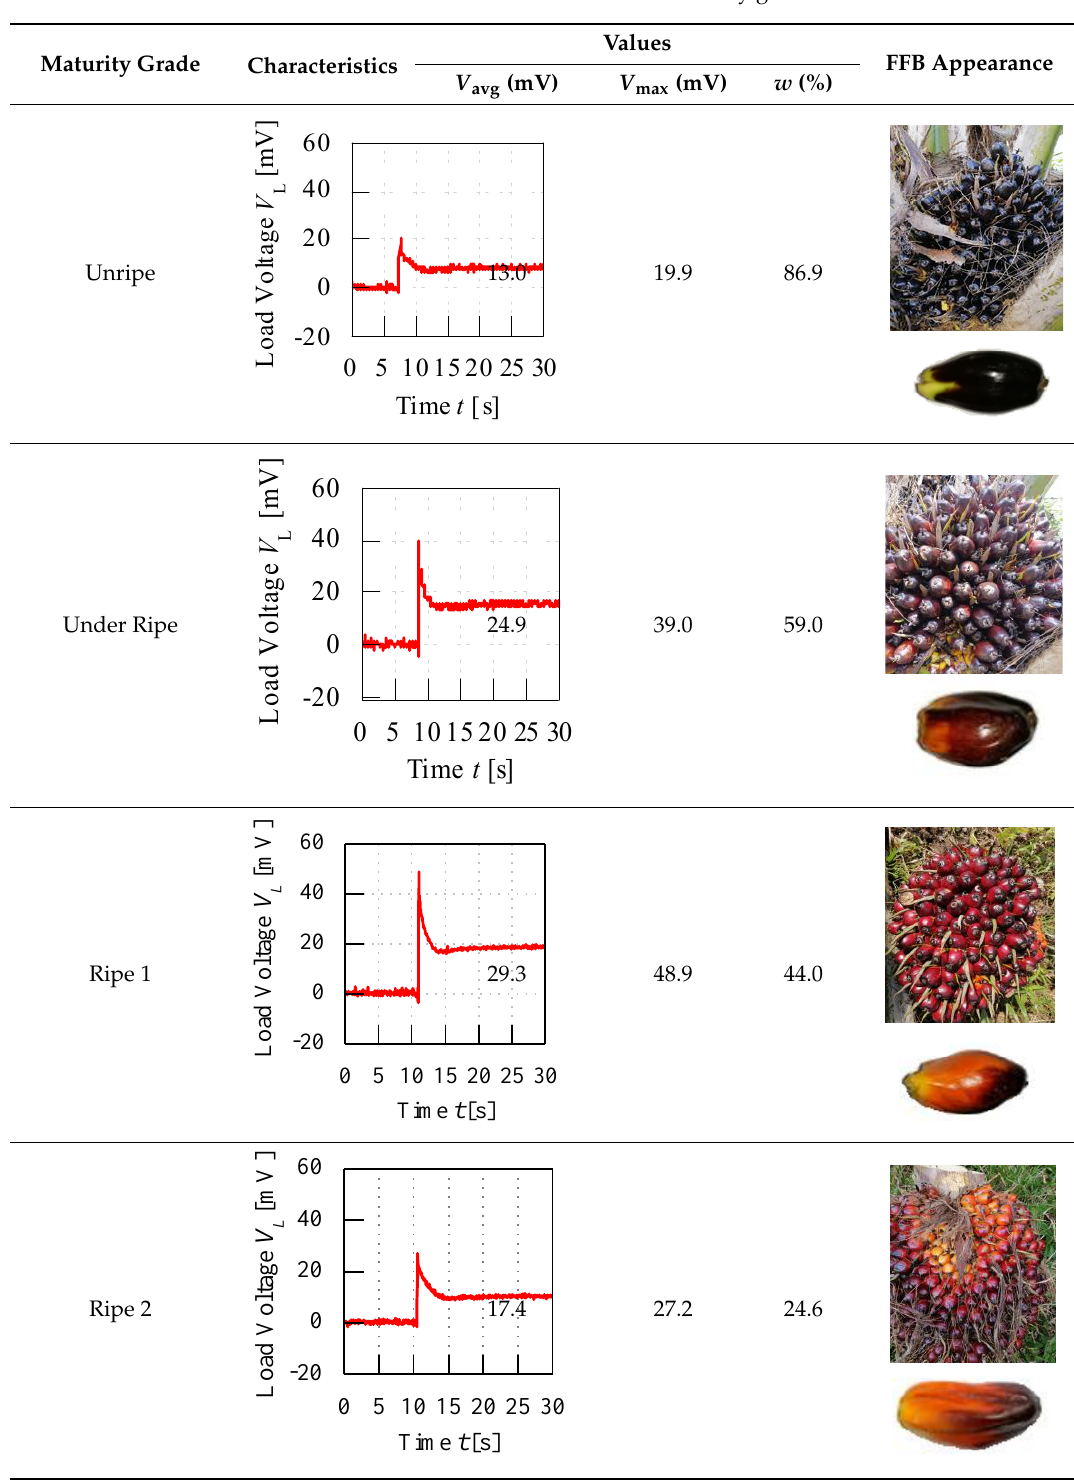
Table 2. Characteristics of various fruit maturity grade.